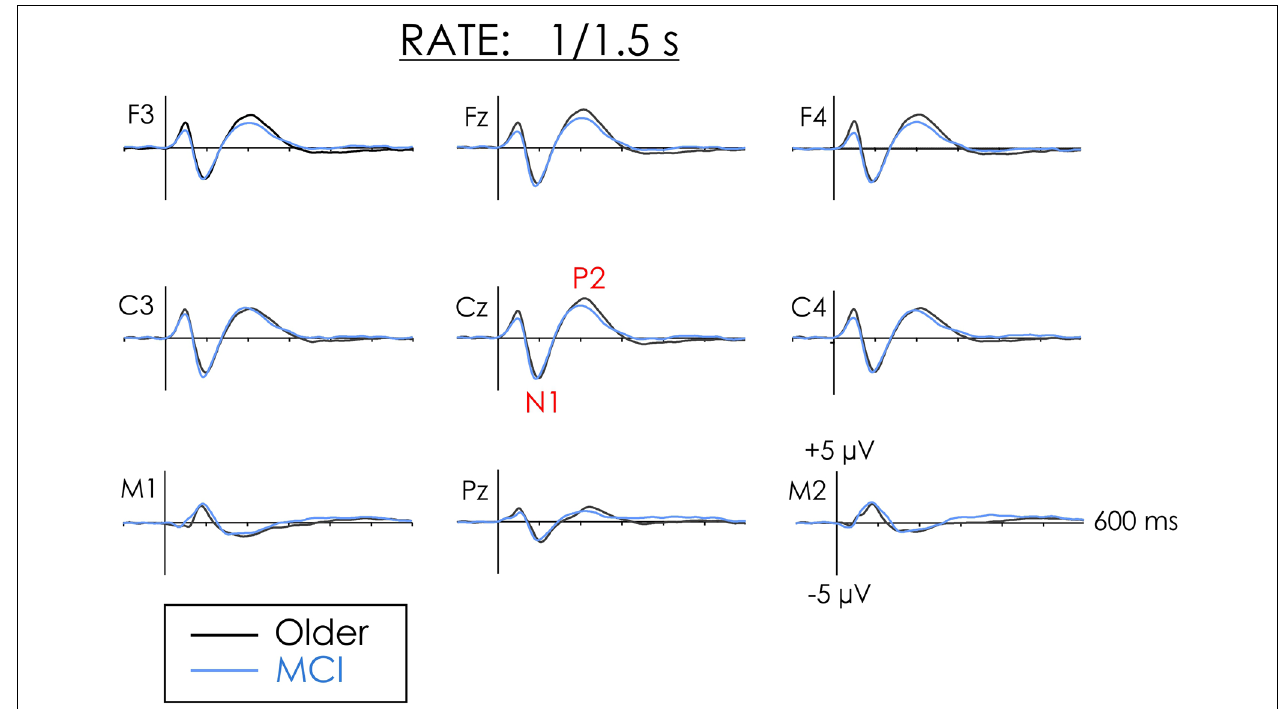
FIGURE 1 | Grand averaged event-related potentials (ERPs) from healthy older adults and people with mild cognitive impairment (MCI) in the fast rate of presentation condition. N1 and P2 amplitude did not differ between the two groups.